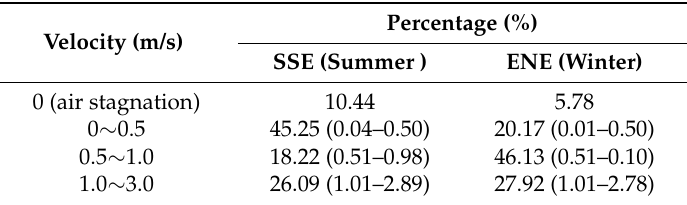
Table 4. The percentage of the wind speed, with the observed minimum and maximum speed values in